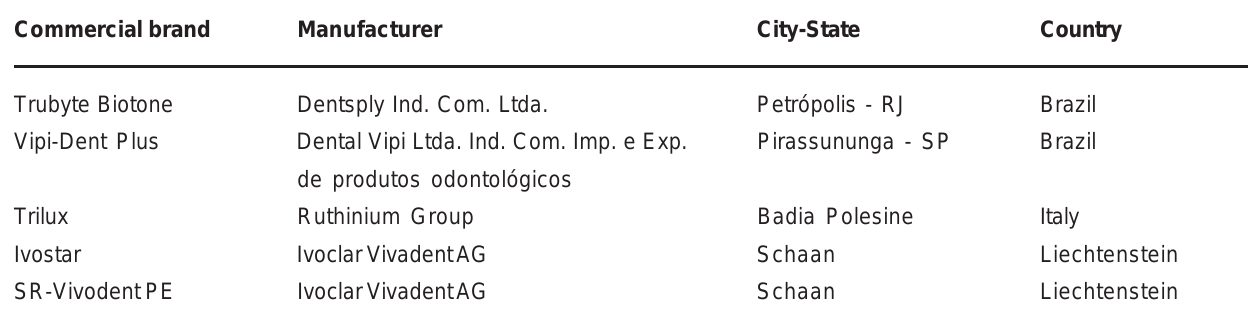
TABLE 1- Specifications of artificial teeth tested